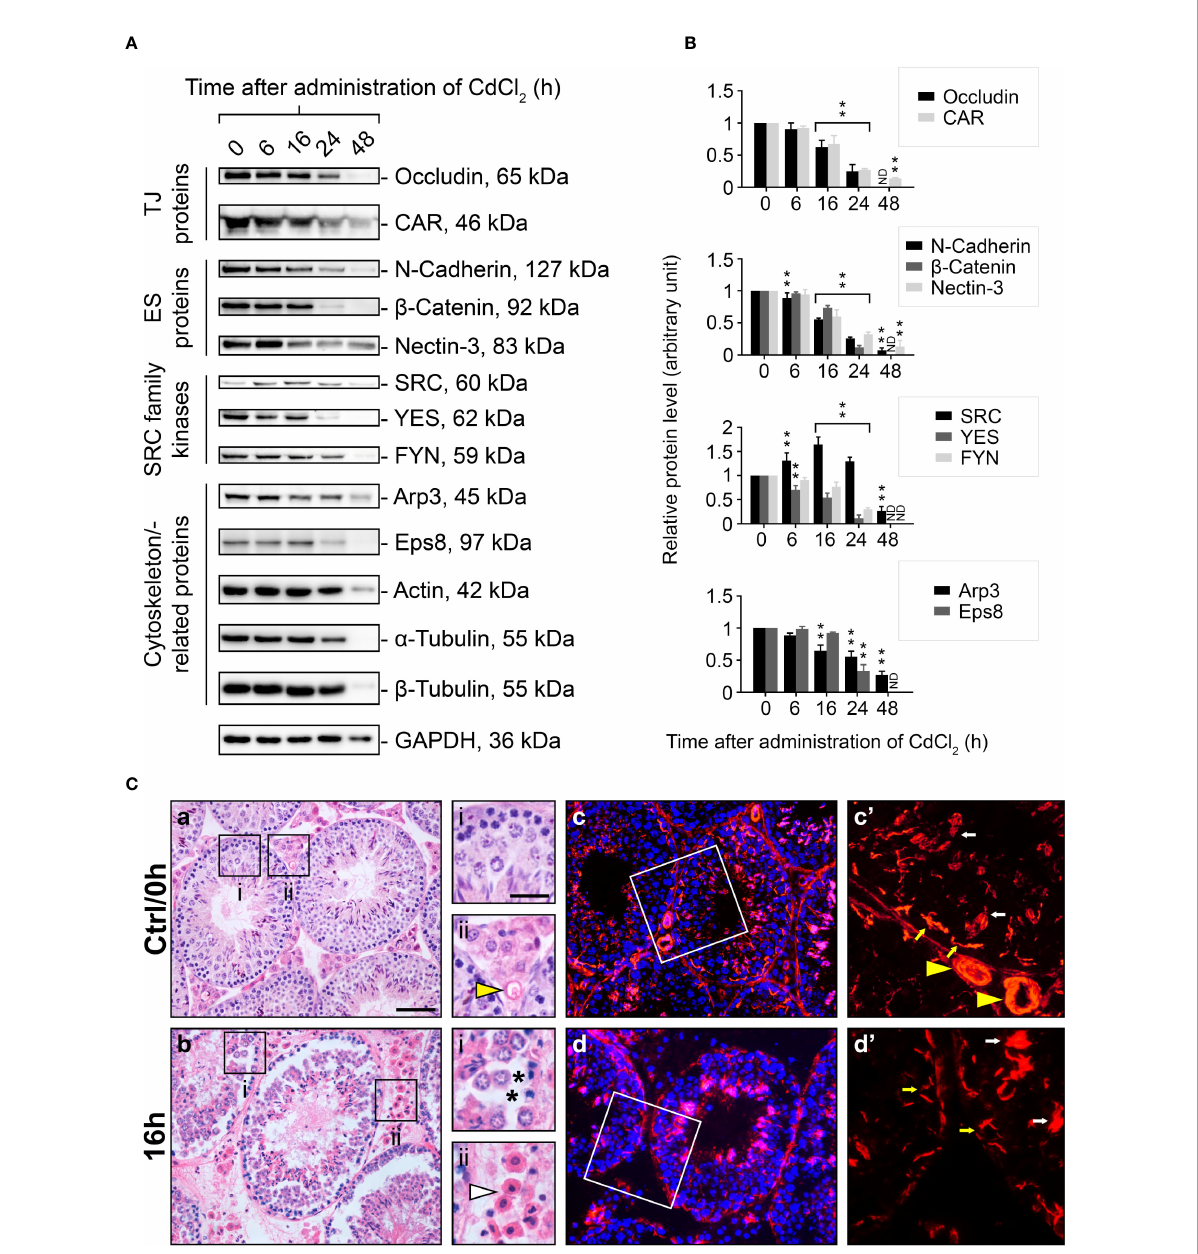
FIGURE 4 A study to assess changes in BTB/apical ES-associated protein levels, testis morphology, and F-actin distribution following CdCl 2 administration. Immunoblotting experiments showing changes in levels of TJ, ES proteins, and SRC family kinases, as well as cytoskeletal proteins (A) . GAPDH was used as an internal control. Histograms (B) summarizing immunoblotting results. A normalization was performed by comparing each data point to its corresponding GAPDH data point and then to ‘ 0 h ’ , which was set to 1 arbitrarily. Each bar represents the mean ± S.D. of n=7-10 mice. **P<0.01 by one-way ANOVA with Dunnett ’ s test. ND, not detected. The histogram for actin, a - and b -tubulin is not shown. As part of the SRC family, SRC was up- regulated in testis following CdCl 2 treatment, while YES and FYN was down-regulated. (C) Representative images of H&E staining of 5 m m-thick paraf fi n-embedded sections (a, b) and immuno fl uorescence staining of 7 m m-thick frozen sections (c, d) obtained from control (Ctrl/0h) and 16-hour CdCl 2 -treated mice (16h). DAPI was used to visualize nuclei (c, d) . The boxed areas (in a, b, c , and d ) correspond to magni fi ed images which are shown to the right of each low magni fi cation image. Yellow arrowheads (Ctrl/0h, ii and c ’ ) refer to intact blood vessels in the interstitial tissue of the testis. Asterisks (16h, i) indicate tears in the seminiferous epithelium after germ cells have detached. White arrowhead (16h, ii) points to out fl ow of blood cells indicating testicular hemorrhage. Yellow and white arrows (c ’ , d ’ ) denote the expected locations of the BTB and apical ES, respectively. Bar ( a , also applies to b, c , and d ) = 25 m m; bar (i, also applies to ii, c ’ and d ’ ) = 10 m